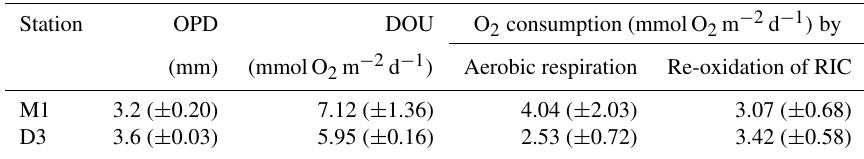
Table 2. Oxygen penetration depth (OPD), diffusive oxygen utilization (DOU) rate and O 2 consumption rate by aerobic respiration and re-oxidation of reduced inorganic compounds (RIC) in the pore water. Values represent averages ± 1SD ( n = 3).